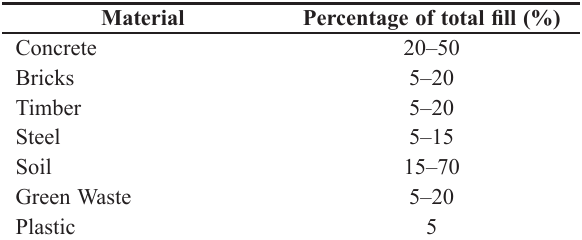
Table 2. Compositions of C&DW in Europe (EPA,